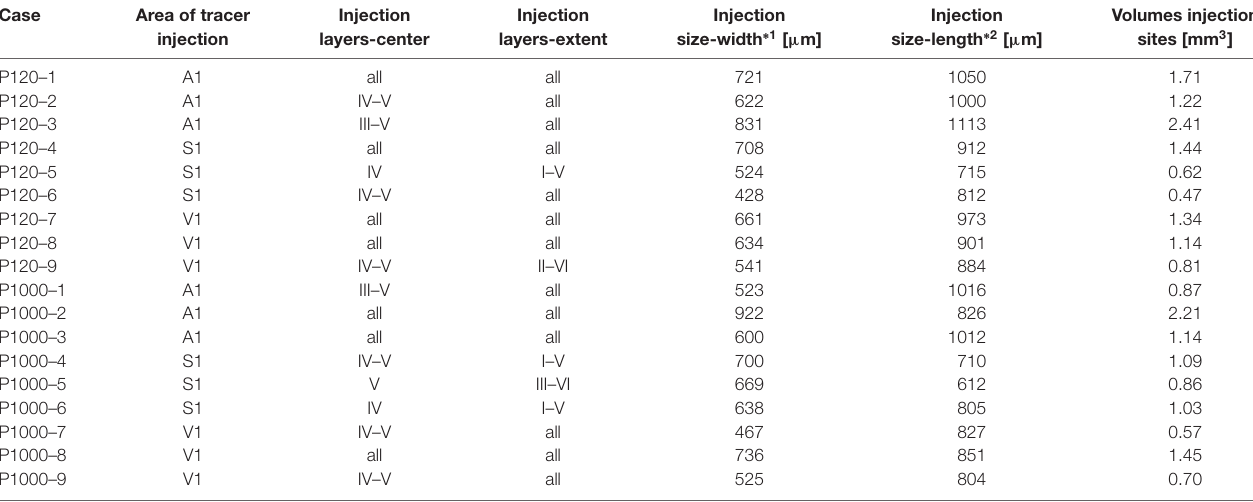
TABLE 1 | Case numbers of experimental animals, cortical areas and layers of Fluorogold (FG) injections, extent and size of tracer injection